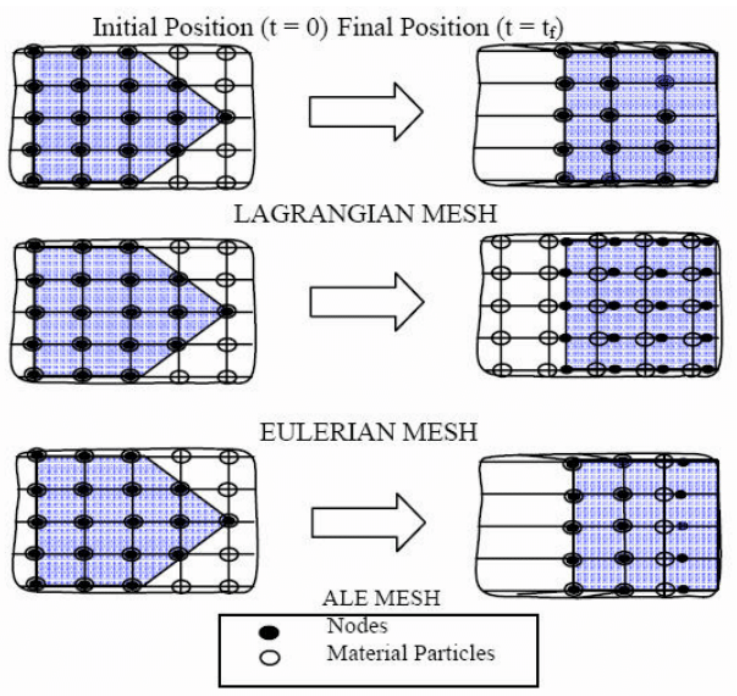
Figure 2. Different welding zones.